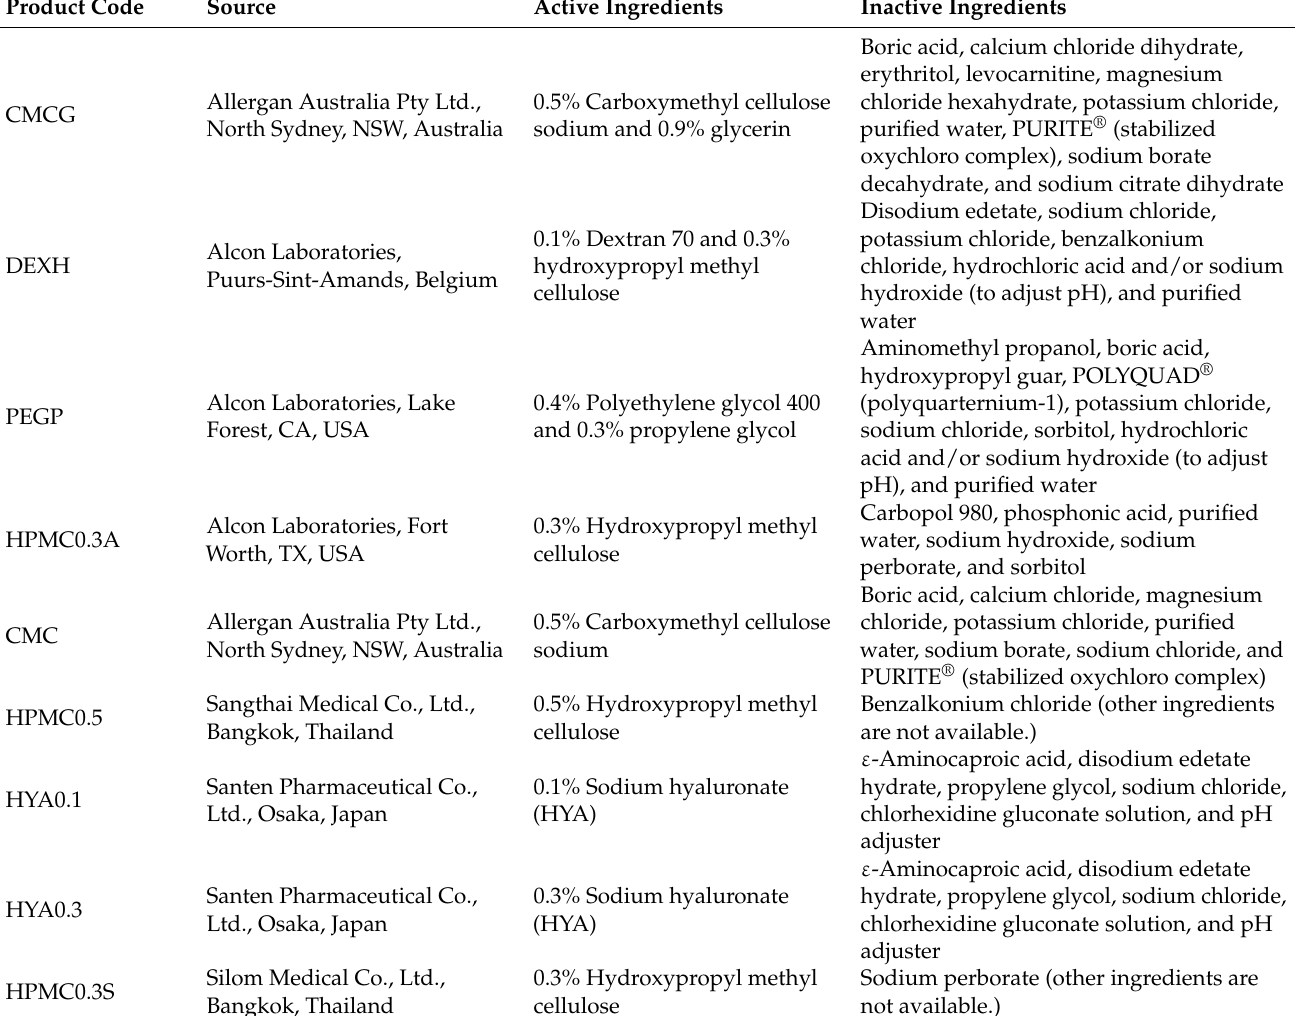
Table 1. A list of commercial artificial tear products used in this study with their source and compositions as stated in the product information or